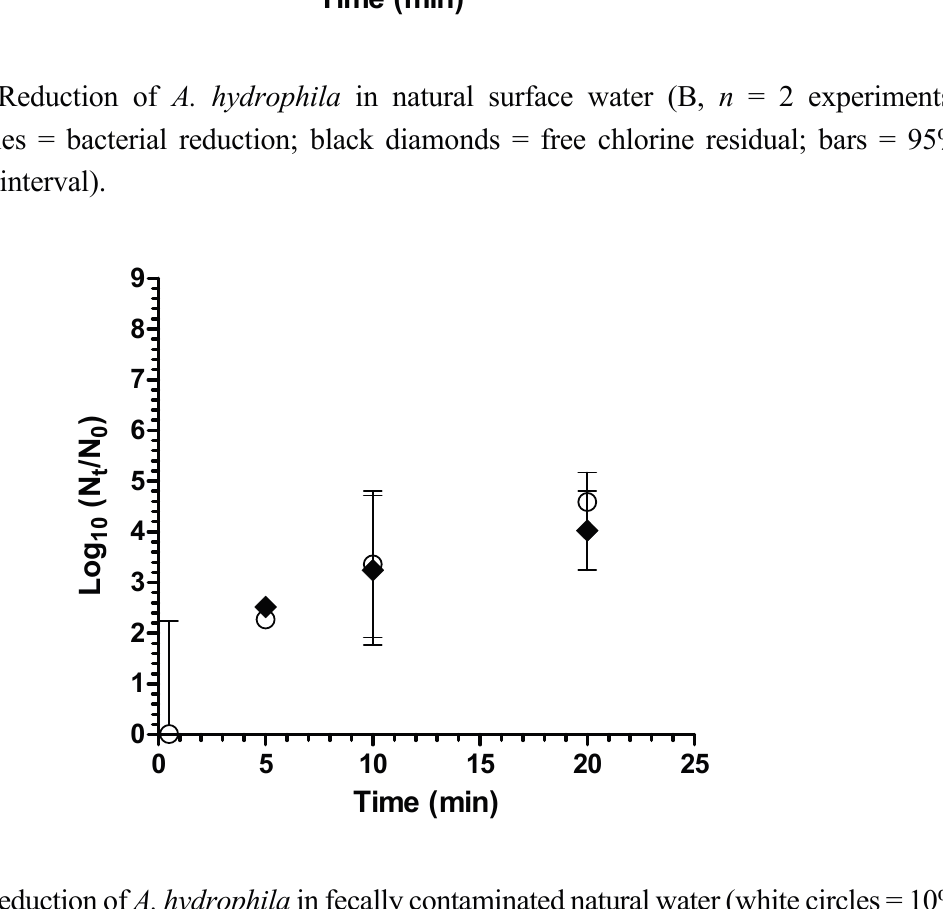
Figure 3. Reduction of A. hydrophila in fecally contaminated natural water (white circles = 10% primary effluent; black diamonds = 20% primary effluent; bars = 95% confidence